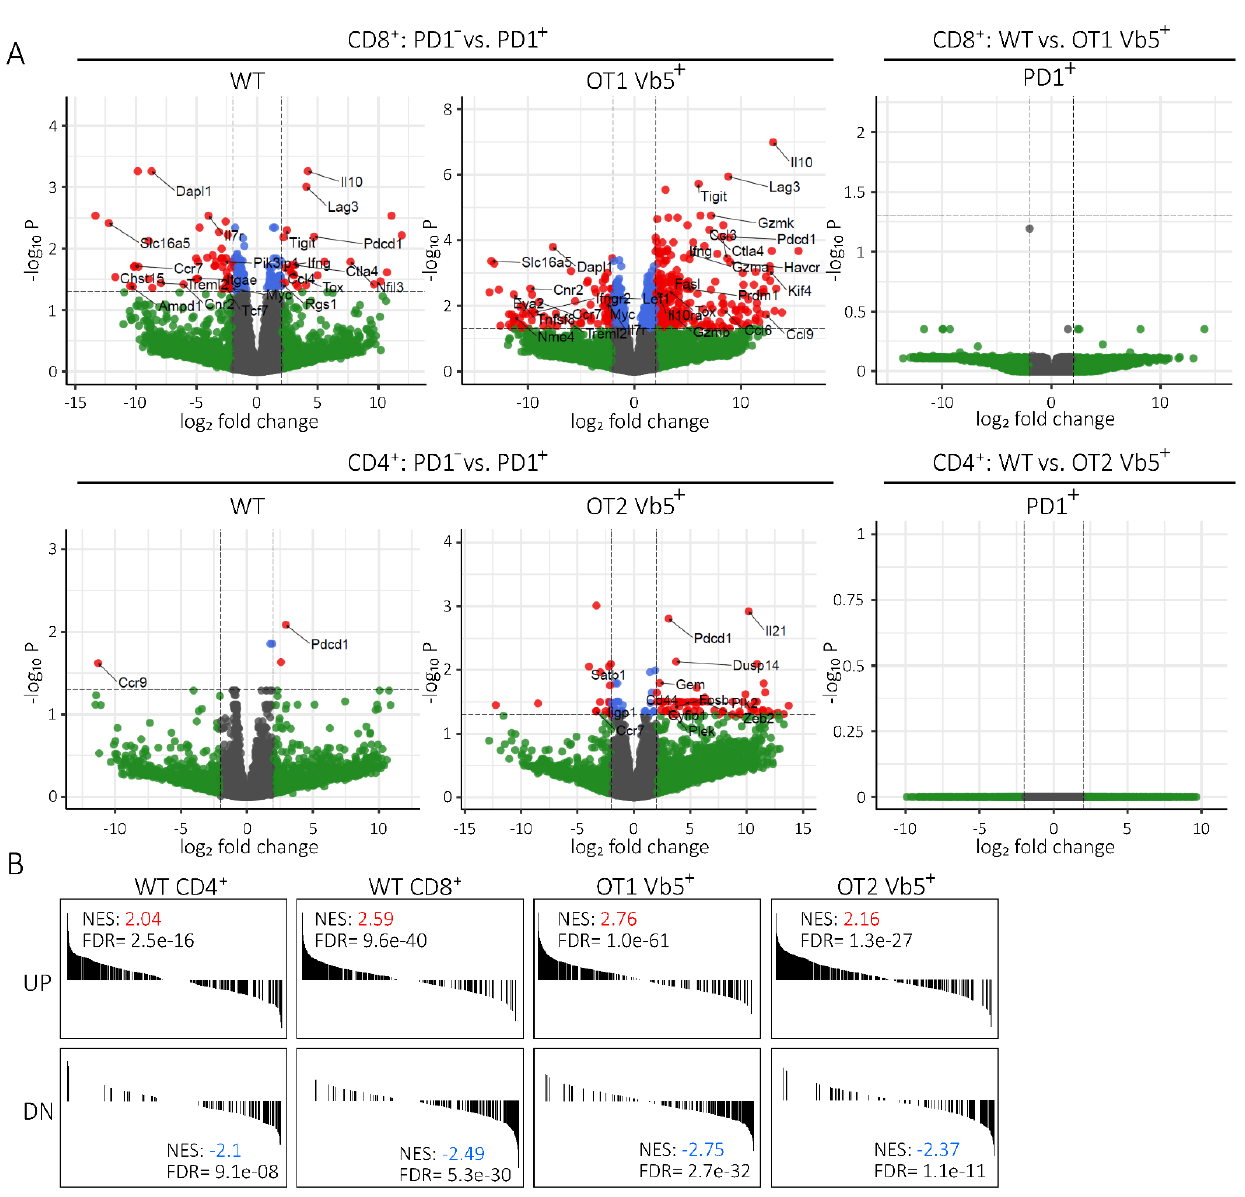
Figure 4. Gene expression profiling of sorted WT and OT Vb5-specific PD1pos T cells. ( A ) Differential gene expression analysis of PD1pos and PD1neg populations of CD8 (upper panel) and CD4 (lower panel), WT (all Vbpos) and OT1 or OT2 (Vb5pos) T cells. Log fold change ( x -axis) is plotted against p values ( y -axis) for each comparison. Genes upregulated or downregulated with a fold change ≥ 2 and an FDR <0.05 are depicted in red. Exemplary deregulated genes of the exhaustion gene sets defined by Crawford et al. [19] are annotated within the graphs. ( B ) GSEA of PD1pos versus PD1neg populations of CD4 and CD8 WT T cells and CD8 or CD4 Vb5pos T cells of OT1 and OT2 mice, respectively. CD4 and CD8-specific exhaustion gene sets defined by Crawford et al. were used for analysis [19]. Genes significantly upregulated in exhausted cells are shown in the upper panels and downregulated genes are shown below. UP: upregulated; DN: downregulated; GSEA: gene set enrichment analysis; NES: normalized enrichment score; FDR: false-positive detection